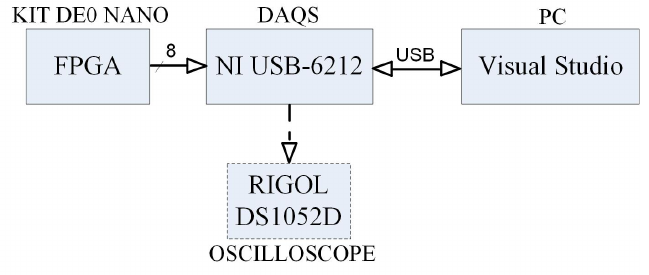
Figure 25. Blocks outline of the experimental installation.